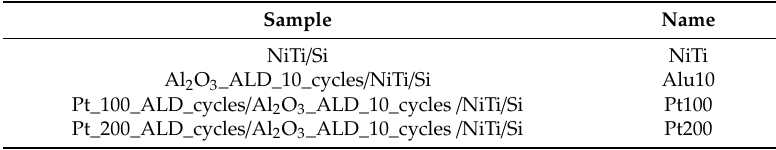
Table 1. A list of the film samples and their short names used in the further